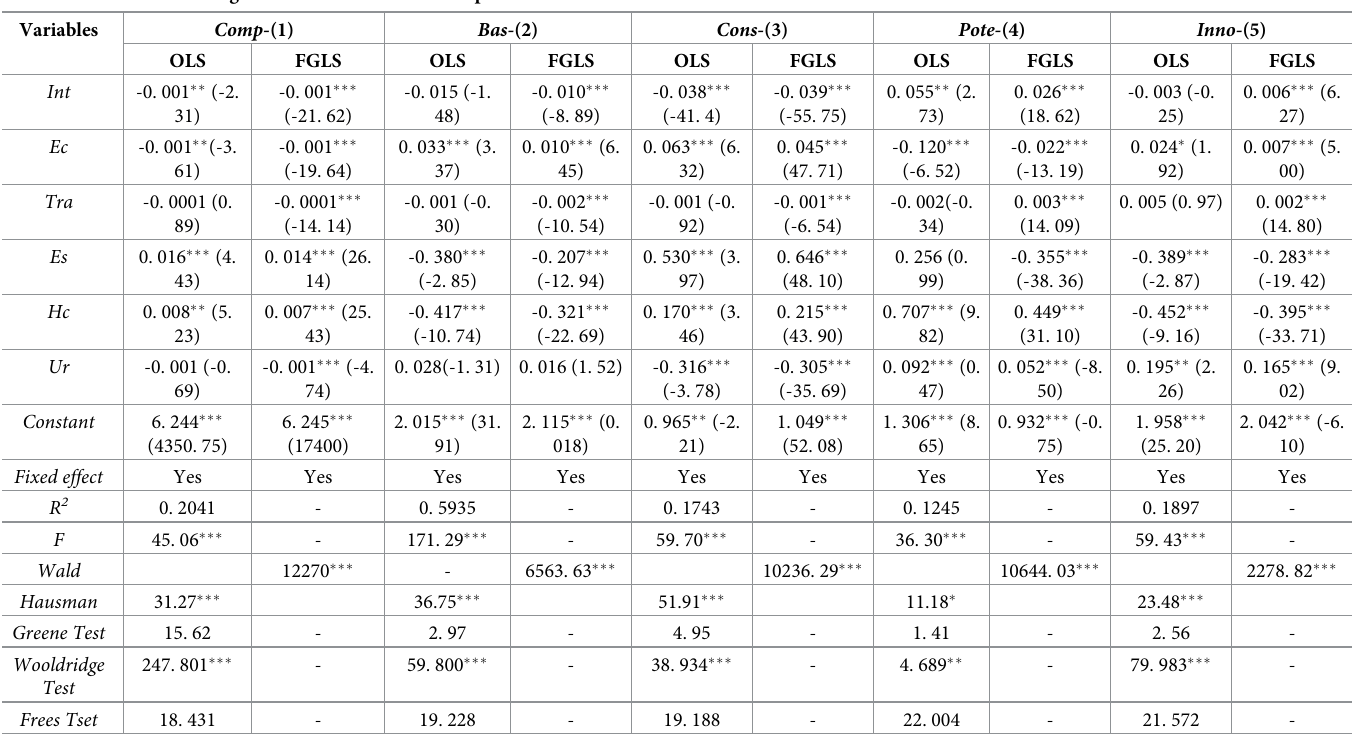
Table 6. Influence of intelligentization on industrial